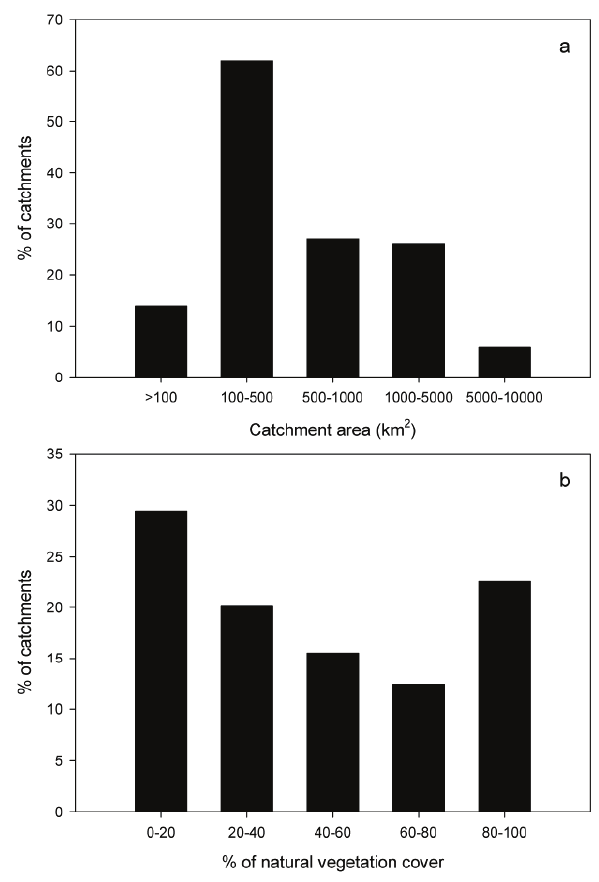
Fig. 2. Percentage distributions of Long Term Series Average (LTSA) catchments according to size of catchment (a) and percent of catchment under natural vegetation cover (b) .